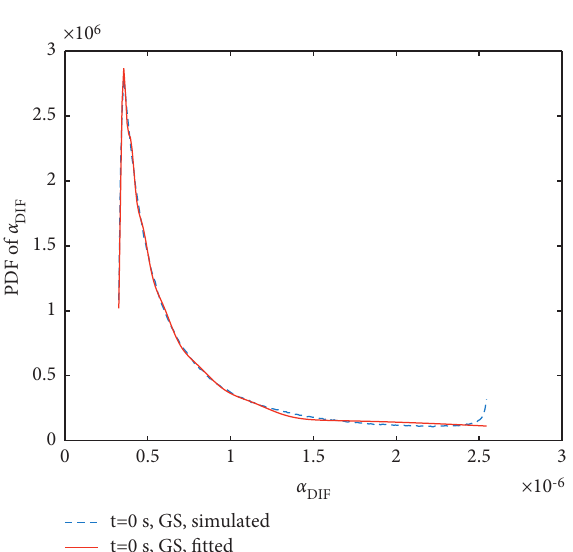
with ϵ � 3 . 57. DIF